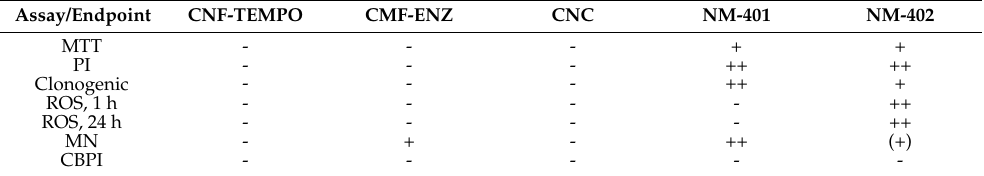
Figure 9. Results of the micronucleus assay after A549 cells’ exposure to the three nanocelluloses: ( A ) CNF-TEMPO, ( B ) CMF-ENZ, and ( C ) CNC, and to the two MWCNT: ( D ) NM-401, ( E ) NM-402 at different concentrations. Columns represent the frequency of micronucleated binucleated cells (MNBC) per 1000 binucleated cells (BNC); the dotted line represents the cytokinesis-blocked proliferation index (CBPI). Mitomycin C, 50 µ g/mL was used as the positive control (PC). The results are expressed as mean ± SD. * Denotes a statistically significant difference from the control ( p < 0.05). An overview of the results obtained for the endpoints analyzed is presented in Table 3. Table 3. Summary of the results of the cytotoxicity, reactive oxygen species (ROS) formation, and genotoxicity endpoints